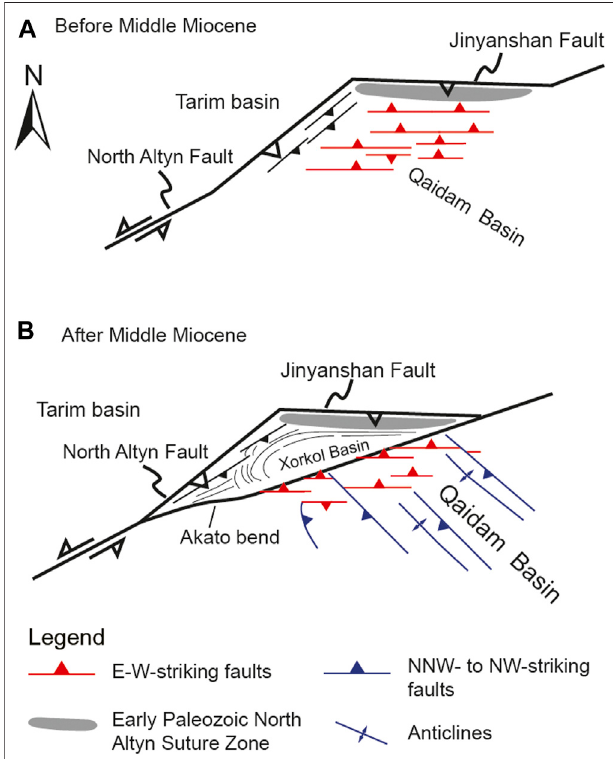
FIGURE 8 | Diagrams illustrating the possible genetic relationships between the two fault systems and the bordering Altyn Tagh fault system. Modi fi ed from Wu et al. (2019). Lineation in the Altyn Shan modi fi ed from Wang et al., 2008.